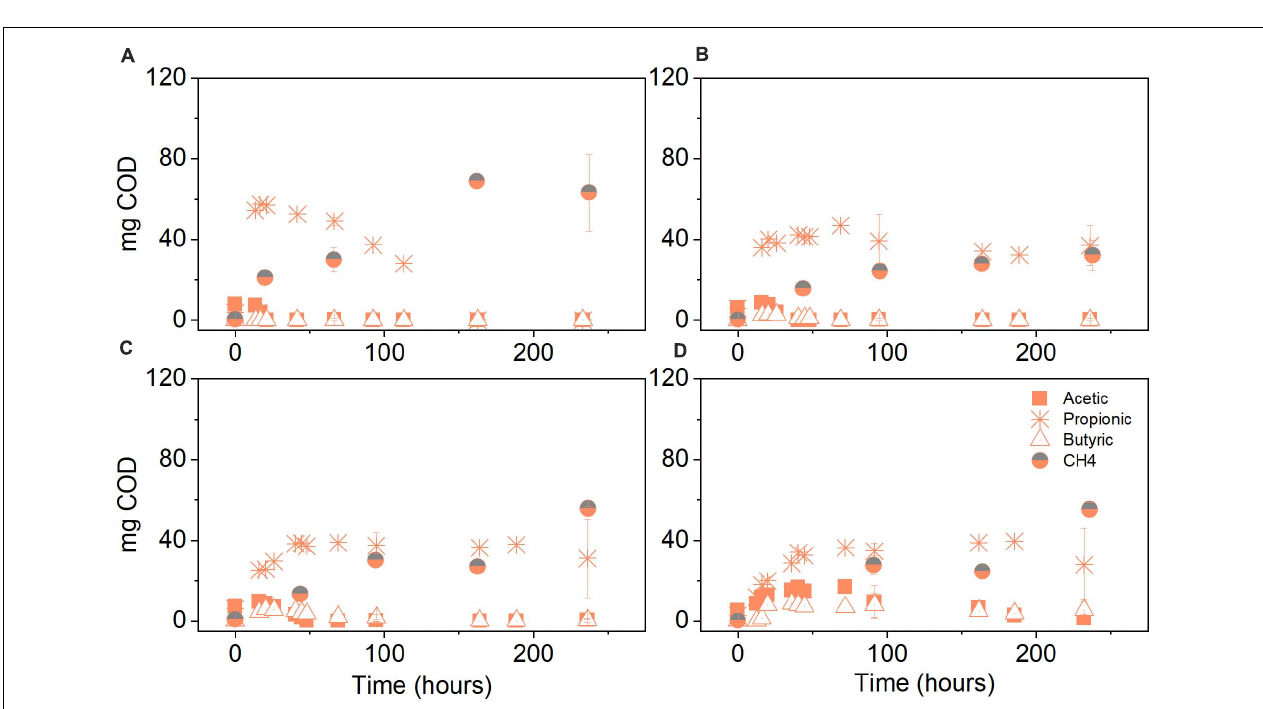
FIGURE 3 | Heatmap presenting the relative abundance of (A) Bacterial community and (B) Archaeal community at the genus level. Experimental treatments correspond to glucose conversion at elevated pCO 2 using original (0.3, 3, 5, and 8 bar) and evolved inoculum (5 bar–E5). I corresponds to the original inoculum and E to the evolved inoculum. Pressure corresponds to initial values before equilibrium.